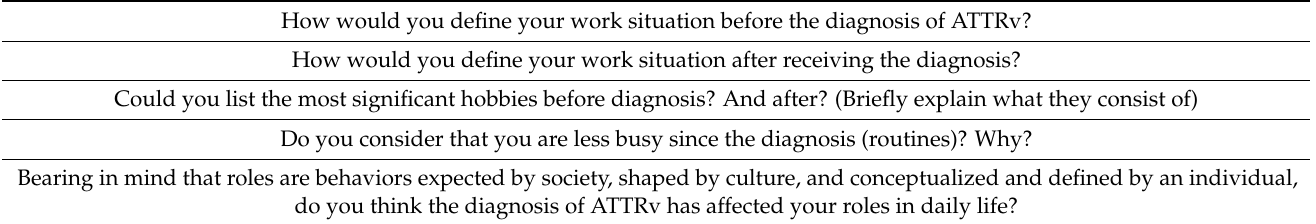
Table 1. Occupational interview questions.